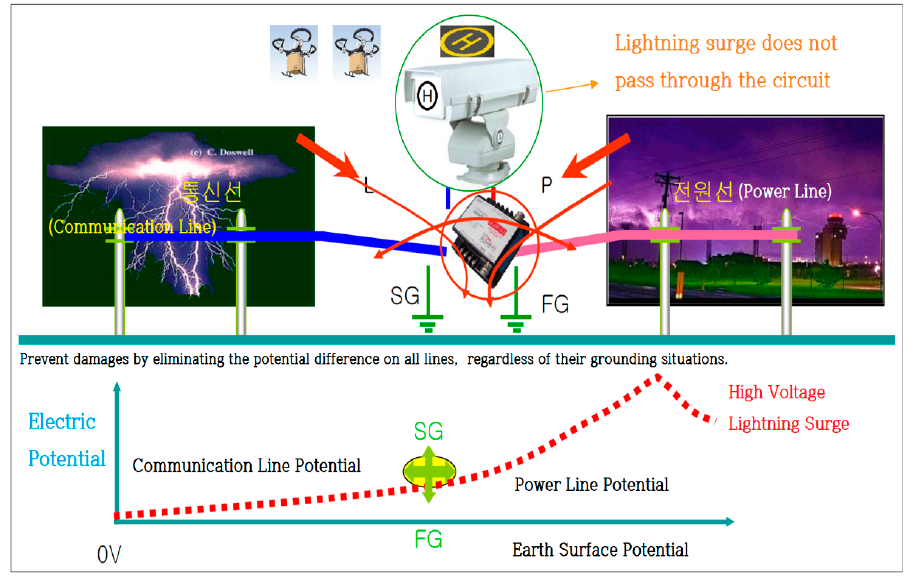
Figure 6. Principle of protection.